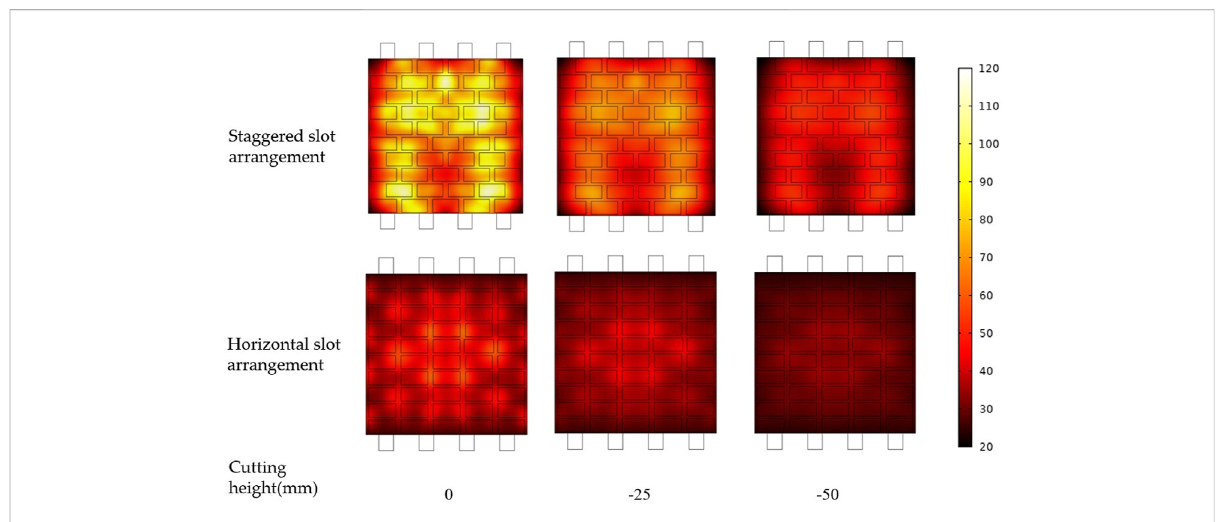
FIGURE 6 Temperature distribution of cross sections of heat absorbing materials for staggered and horizontal slot